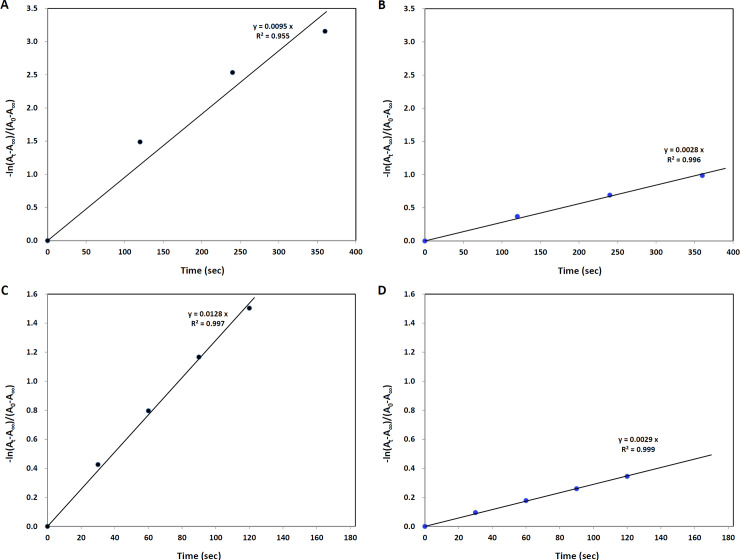
Examples for plotting time versus–ln(At − A∞)/(A0 − A∞) in determining the fading rate constant (k).(A) A plot for an NKT gray photochromic lens at λmax1 at the warm temperature. (B) A plot for an NKT gray photochromic lens at λmax1 at the cold temperature. (C) A plot for an NKT gray photochromic lens at λmax2 at the warm temperature. (D) A plot for an NKT gray photochromic lens at λmax2 at the cold temperature.